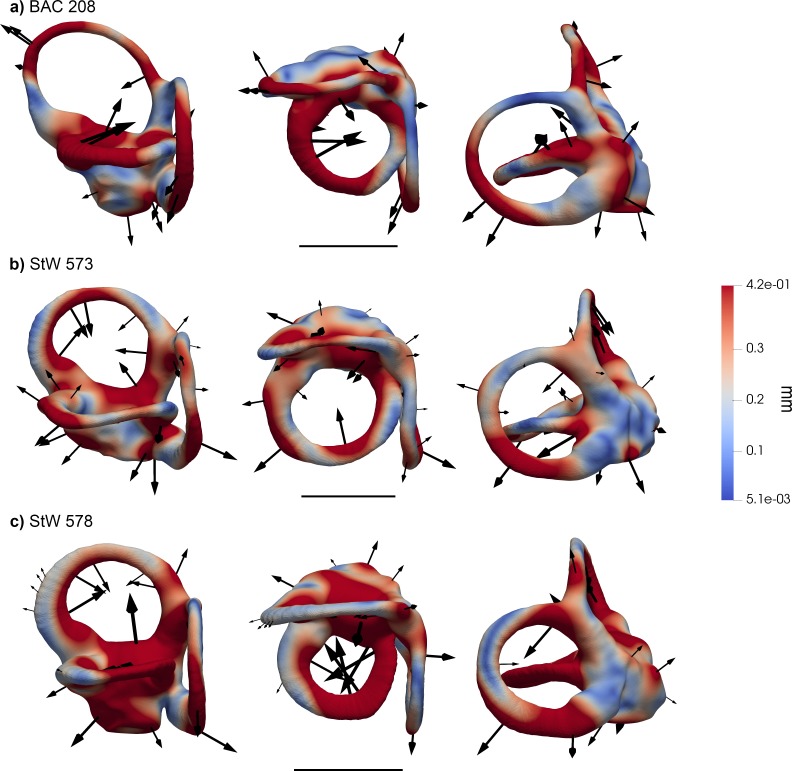
Results of the 3DGM deformation-based analysis superimposed on the vestibular apparatus of the fossil specimens included in the present study.Each vestibule is displayed in lateral (left), superior (middle), and posterior (right) views. Cumulative displacement variations are rendered by pseudocolor scale ranging from dark blue (<5.1 µm) to dark red (0.42 mm). Black arrows correspond to the vectors identifying the direction and amount of displacement. (a) Oreopithecus bambolii (BAC 208); (b) Australopithecus sp. (StW 573); (c) Australopithecus sp. (StW 578). Scale bars equal 5 mm. Oreopithecus (a) displays large vertical canals and a small, flat lateral one that intersect the plane of the posterior SC. The angle between the anterior and posterior SCs is one of the narrowest among the studied sample. StW 573 (b) and StW 578 (c) differ by means of a larger lateral canal in the previous and by the more rounded and developed anterior SC in the latter.